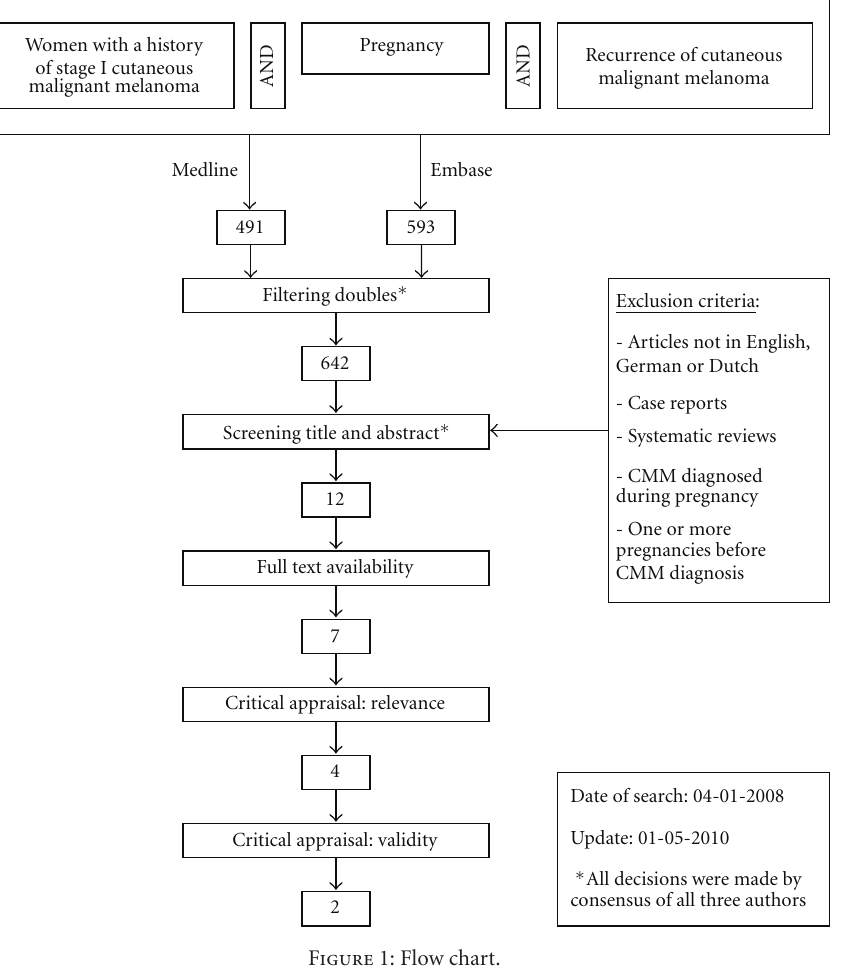
Figure 1: Flow chart.